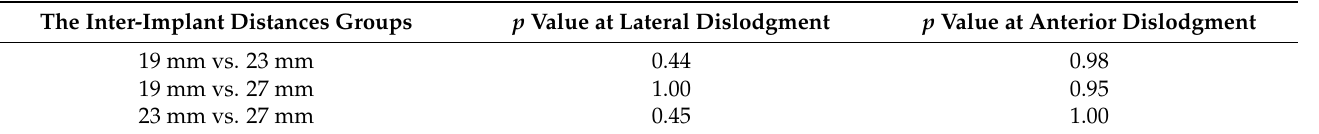
Table 2. The significance level of Tukey post hoc test for lateral and anterior dislodgment within two MDIs groups; the mean difference is significant at the 0.05 level.